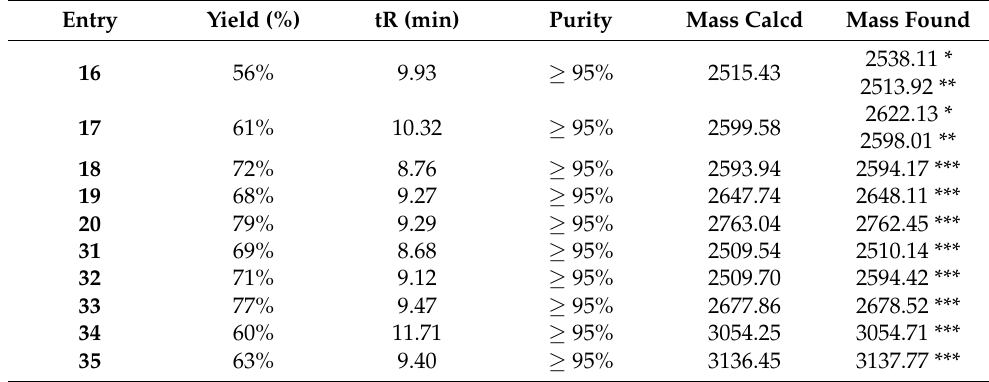
Table 3. Yield, purity, retention times, and analytical data of the described